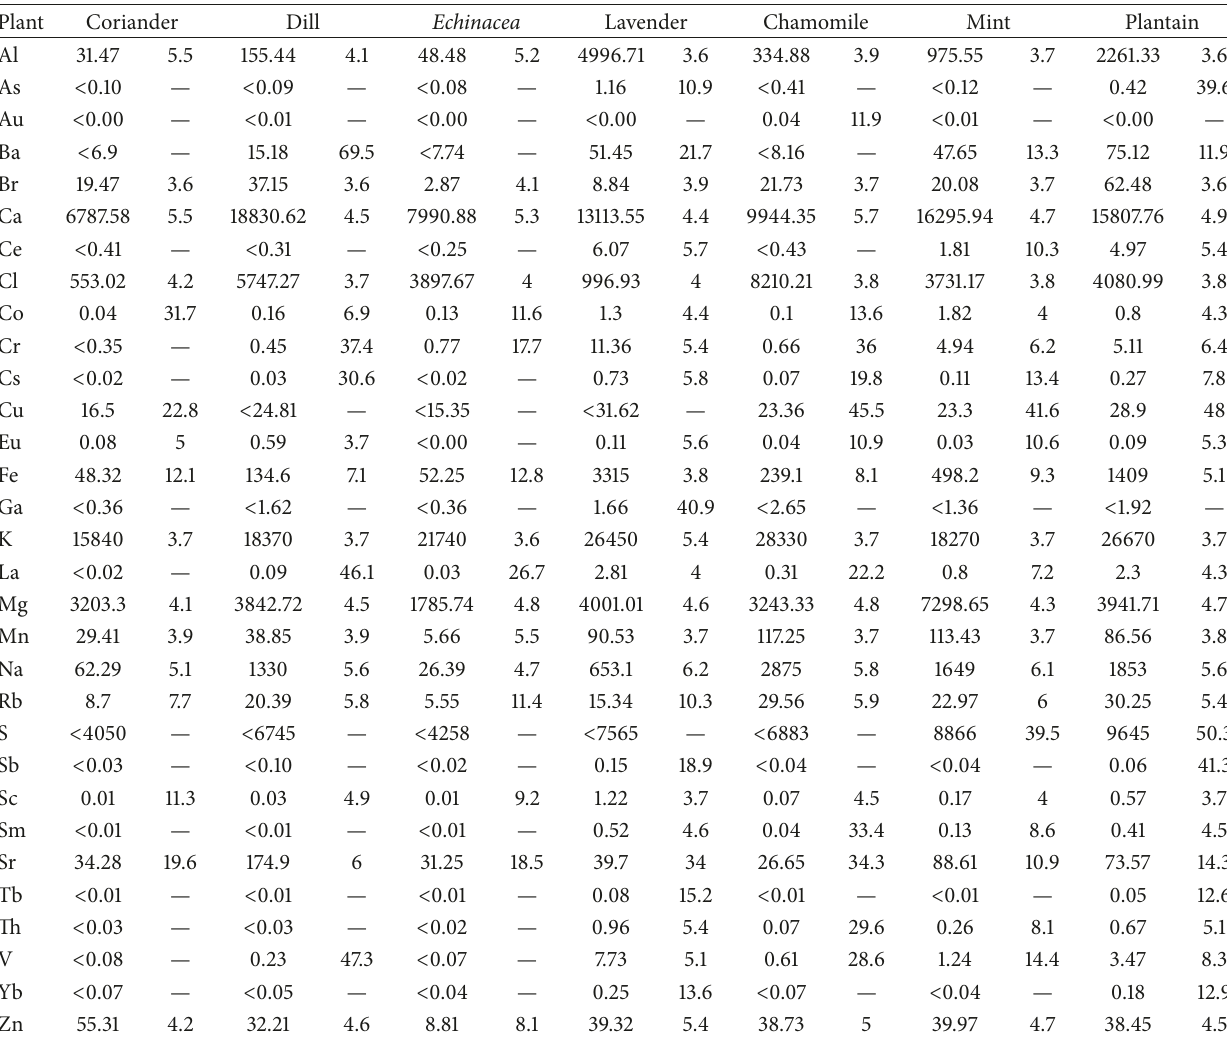
Table 2: Concentration of the elements in representative medicinal plants as obtained by NAA: the values are means (mg ⋅ kg −1 ) and the corresponding relative standard deviations, RSD (% ) ∗ .